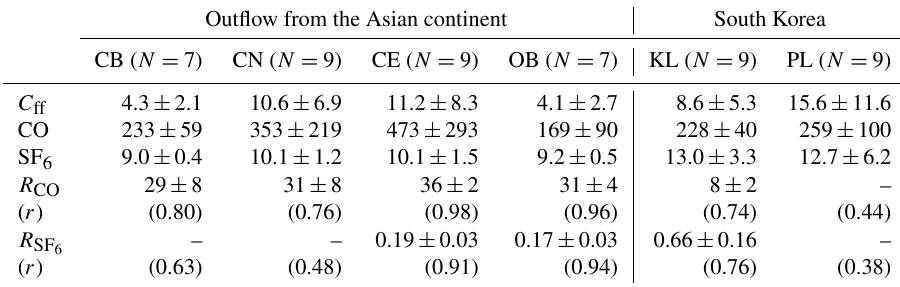
Table 1. Means and standard deviations of C ff (µmolmol − 1 ), CO (nmolmol − 1 ), and SF 6 (pmolmol − 1 ) (total N = 50; without PL N = 41). The correlations ( r ) and the ratio ( R gas ) of enhancement between C ff values were determined by reduced major axis (RMA) regression analysis on each scatter plot to obtain regression slopes. The uncertainty of R gas refers to Eq. (S2). When r is less than 0.7, R gas was not included here. N is the number of data. The unit of R CO is nanomoles per micromole (nmolµmol − 1 ), and for R SF it is picomoles per 6 is shown in Fig. S1 in the Supplement. CB represents continental background, CN micromole (pmolµmol − 1 ). A plot of R CO and R SF 6 northeast China, CE central eastern China, OB ocean background, KL Korean Peninsula local air, and PL polluted local air